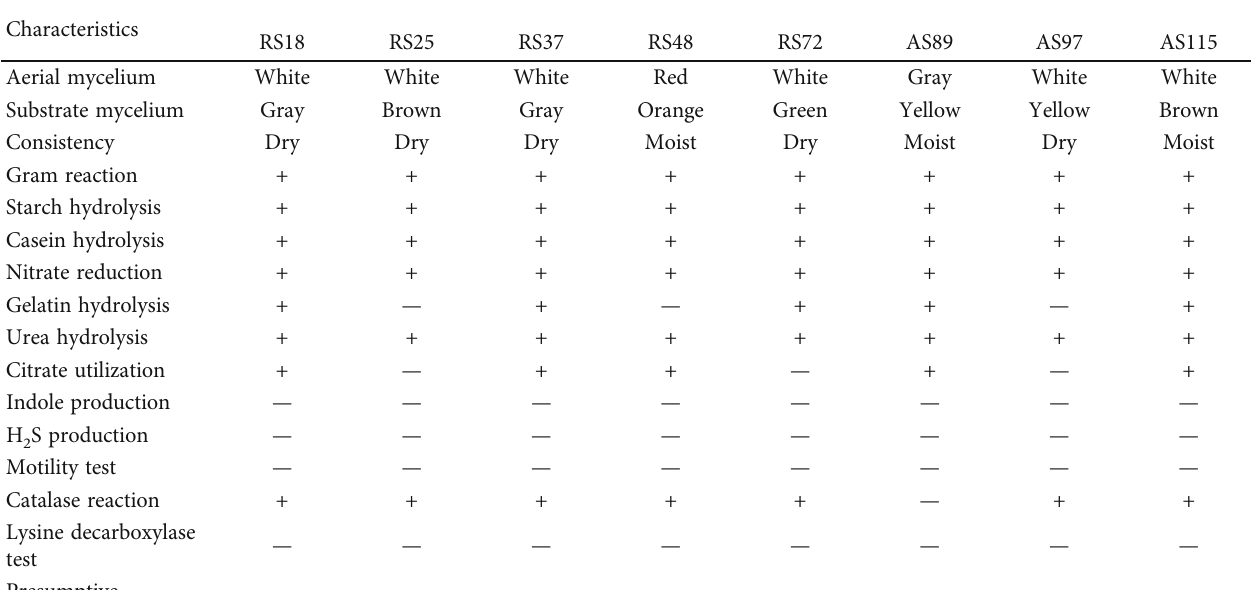
Table 2: The morphological, physiological, and biochemical characteristics of the isolates with broad-spectrum antagonistic activity. Characteristics